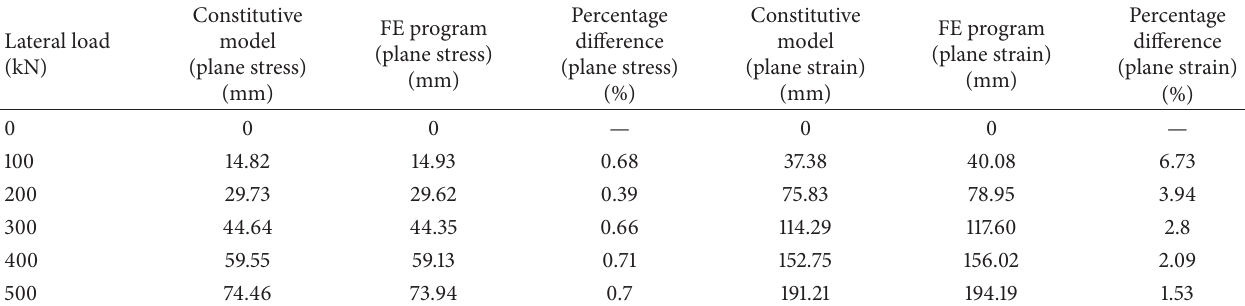
Table 4: Displacement comparison of the constitutive model and FE model of RC2SS at node 1.